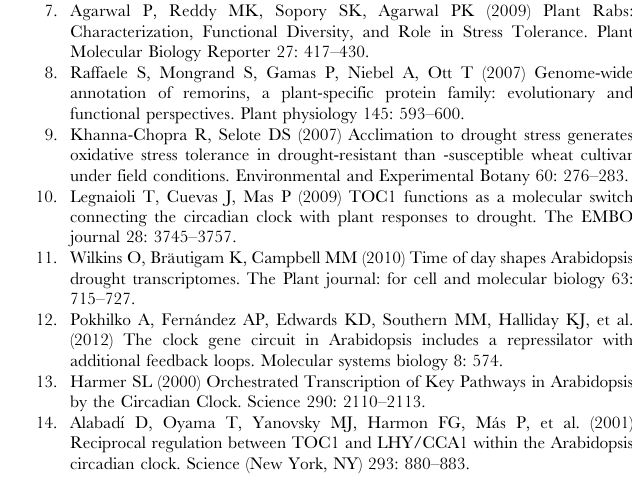
Figure S1 Phylogenetic tree for the PRR genes. The proteins encoded by Arabidopsis AtPRR3, AtPRR7, and AtPRR9, the soybean GmPRR homologs, and its paralogs were used to construct the tree using the ClustalW algorithm in the MEGA 5 program. The Neighbor-Joining method was used with the following parameters: Poisson correction, pairwise deletion, and bootstrapping (1000 replicates; random seed). Figure S2 Model of the impact of severe drought on circadian clock genes. Model of the impact of severe drought stress on GmLCL1 , GmTOC1 , GmLUX and GmELF4-like gene expression. Figure S3 The circadian clock genes that exhibited no response to ABA treatment. Gene expression data regards qPCR analysis. Expression axis represents normalized expression (NE) = 2^ -(Ct experimental – Ctn) . Collect time points are represented